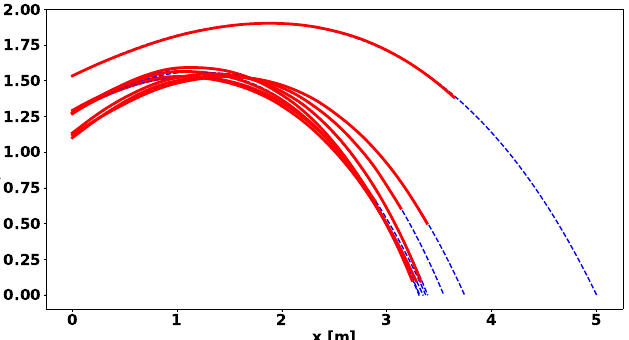
Figure 2. Measured (solid) and simulated (dashed) trajectories after calibration. The short trials were launched from the old and new heights, respectively. The long serve was launched without regard for the